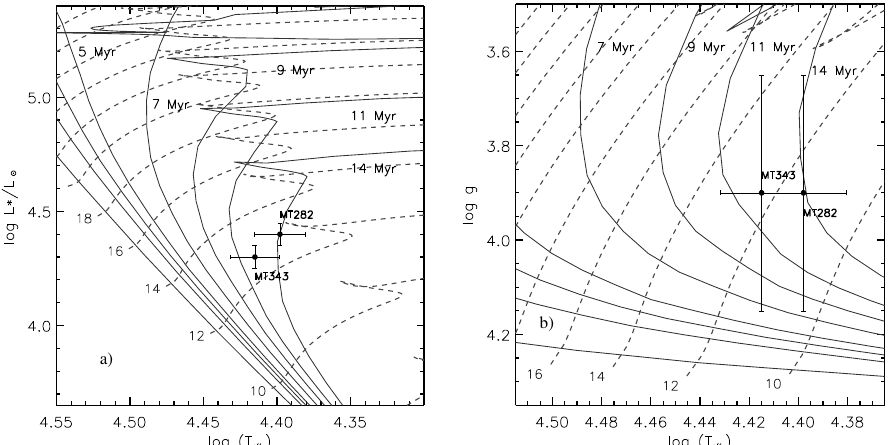
Fig. 3. Location of MT 282 and MT 343 on the HR (left) and log g, T eff (right) dia- grams. Evolutionary tracks (the dashed lines) and isochrones (the dashed-dotted lines) are adopted from Ekstr¨om et al.